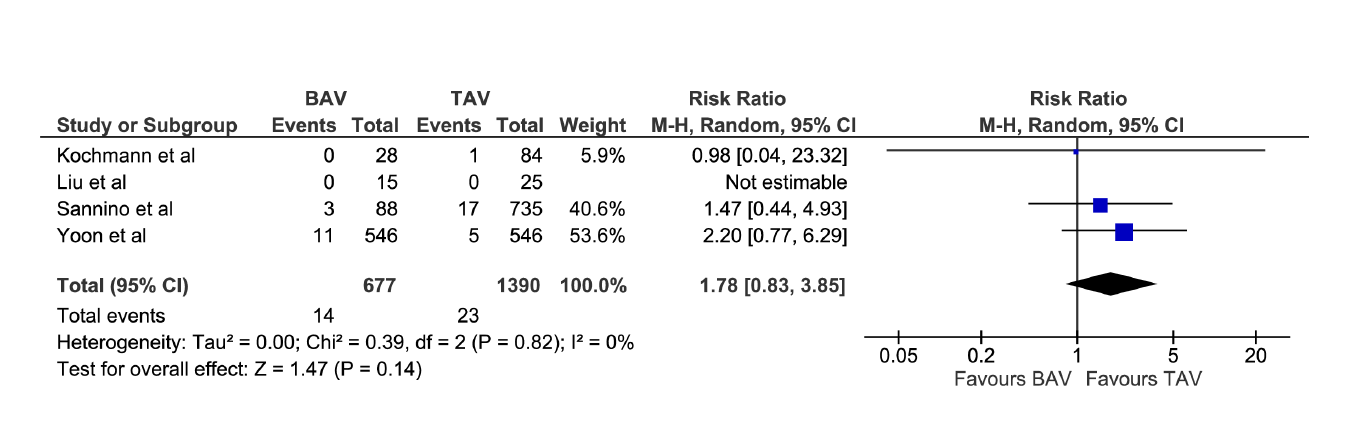
Fig. 3 - Forest plot for postoperative acute kidney injury. BAV=bicuspid aortic valve; CI=confidence interval; M-H=Mantel-Haenszel; TAV=tricuspid aortic